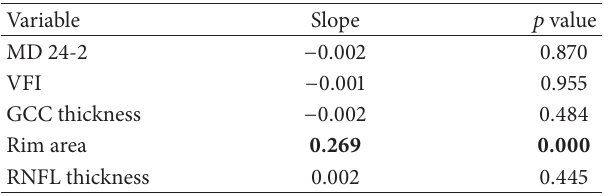
Table 5: Multivariate model for total ONH vessel density 𝑅 2 = 0.387